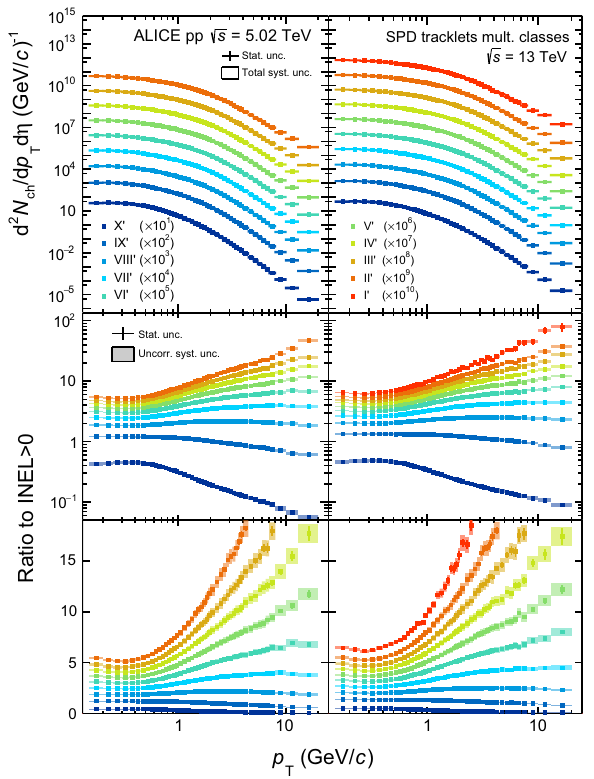
Fig. 2 Transverse momentum distributions of charged particles for multiplicity classes selected using SPD tracklets in | η | < 0 . 8. Results √ s = 5 . 02 and 13TeV are shown in the left and for pp collisions at right panels, respectively. Statistical and total systematic uncertainties areshownaserrorbarsandboxesaroundthedatapoints,respectively.In the middle panels, ratios of multiplicity dependent spectra to INEL > 0 are shown in logarithmic scale. In the bottom panels we show the ratios in a linear scale to illustrate the dramatic behavior of the ratios. The systematic uncertainties on the ratios are obtained by considering only contributions uncorrelated across multiplicity. The spectra are scaled to improve the